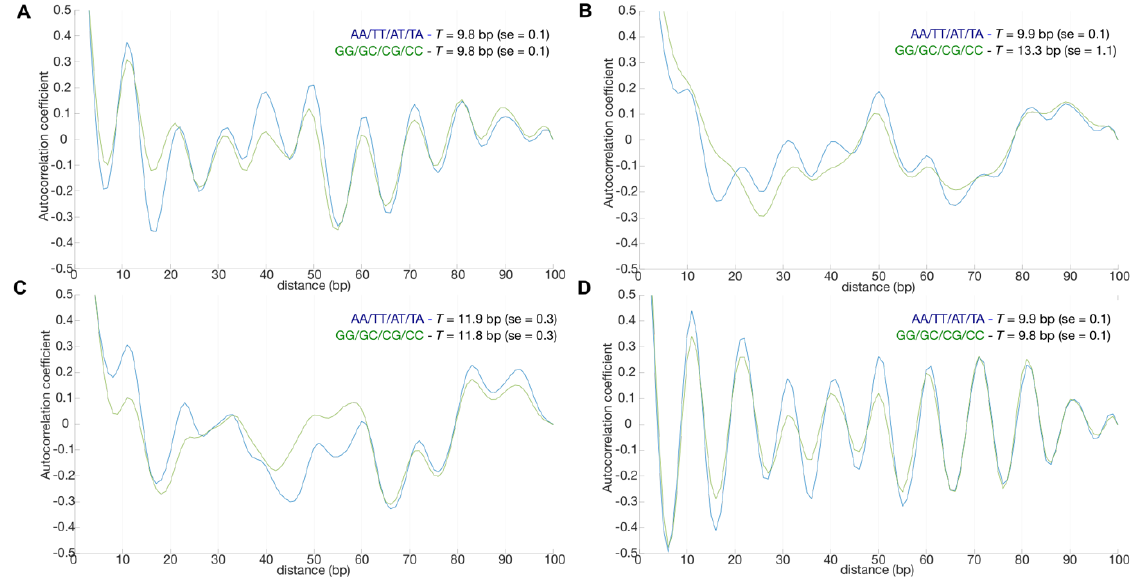
Supplementary Figure 7. Autocorrelation coefficients of di-nucleotide frequencies (average of three biological replicates) for Leptosphaeria maculans ‘brassicae’ ( A ), L eptosphaeria maculans ‘lepidii’ ( B ), Botrytis cinerea ( C ), and Fusarium graminearum ( D ). In blue: autocorrelation for AA/TT/AT/TA frequencies; in green: autocorrelation for GG/CC/CG/GC frequencies. Periodicities T were inferred after linear regression fitting to peak positions as a function of peak rank. Periods, standard errors (se), R 2 (coefficient of determination), and p -values ( F -test) were also determined individually for each replicate (see Supplementary Table 4).